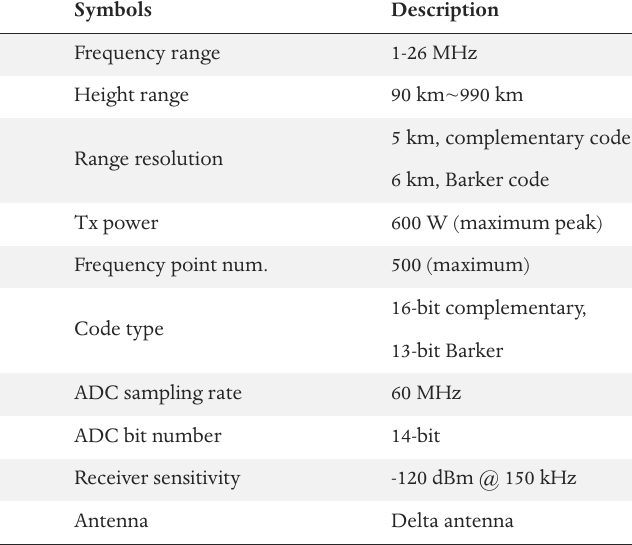
Table 1. The CAS-DIS